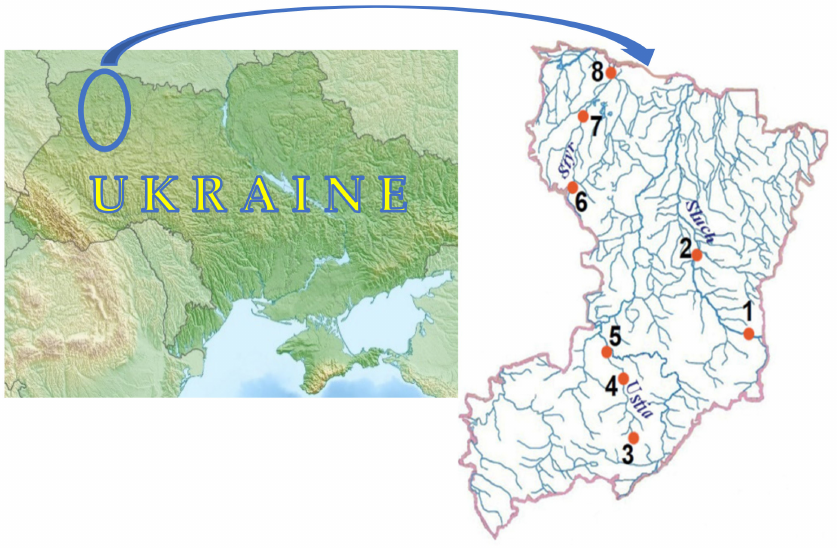
Figure 1. Map and scheme of the water and fish sampling sites (numbers 1–8 are observation posts).